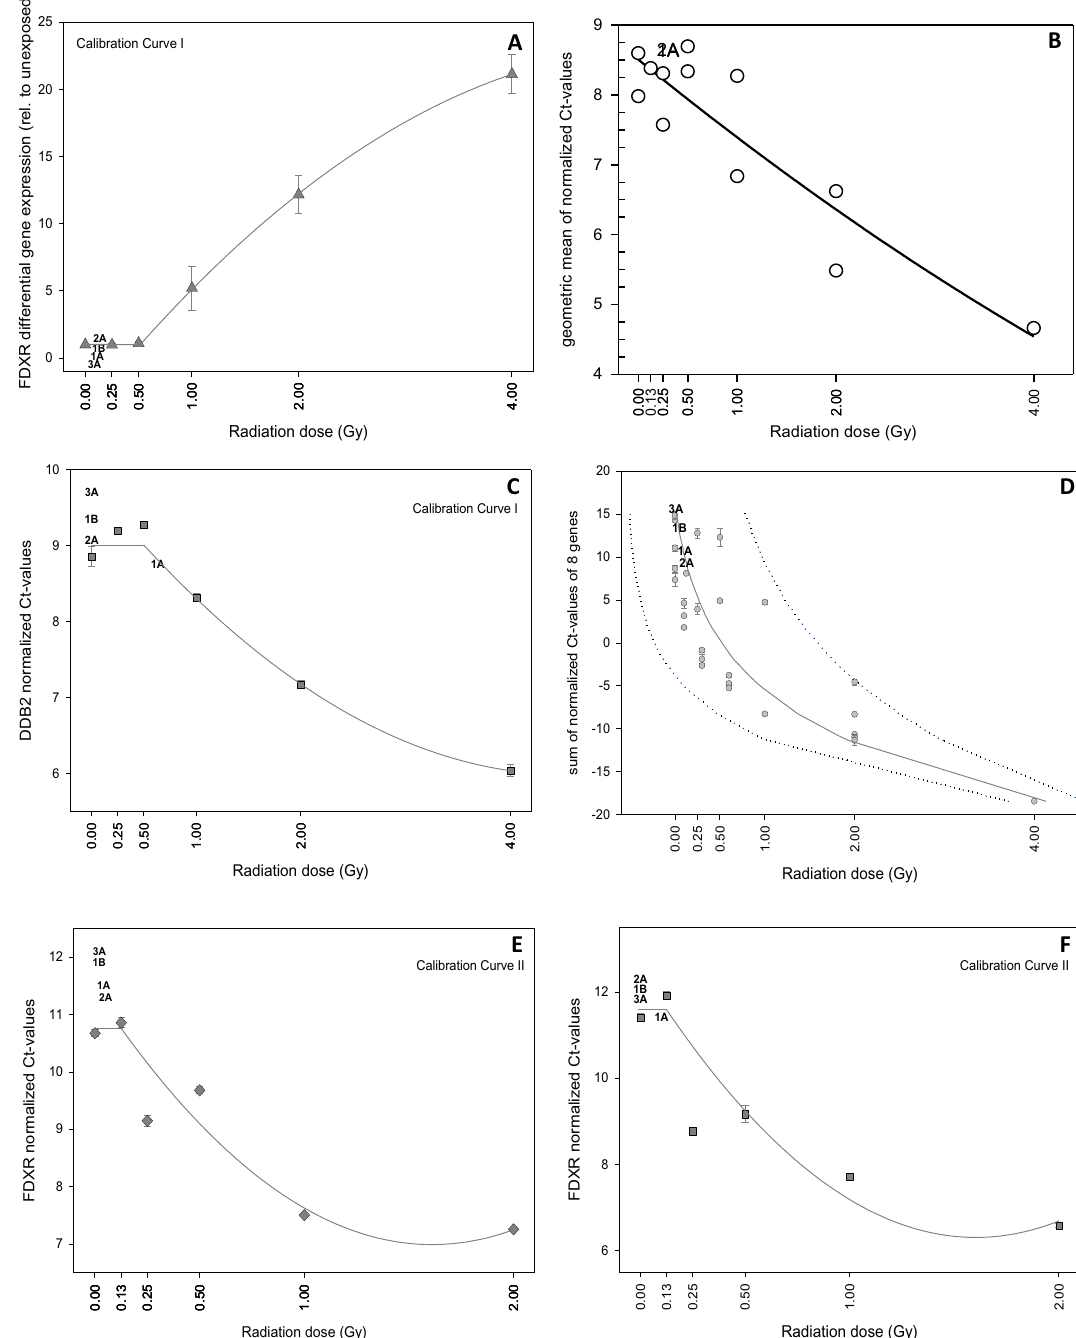
Figure 3. Examples of calibration curves I ( A , C ) and II ( E , F ) and additional calibration curves combined ( B , D ) generated by the different qRT-PCR teams are shown. Gene expression reflected either as differential gene expression (reference was the 0 Gy calibration sample, A ), normalized single genes from two different teams ( C , E , F ), averaged ( B ) or summed Ct-values ( D ) using several genes combined were plotted versus radiation dose (Gy). Normalized and differential gene expression values measured below 0.5–1.0 Gy (calibration curve I) and 0.125 Gy (calibration curve II) were fitted with a horizontal line (assuming a threshold) and higher values using a manual fit. For summed normalized Ct-values of 8 genes ( BAX, BBC3, CDKN1A, DDB2, FDXR, GADD45A, GDF15, TNFSF4 ) and utilizing different calibration curves an exponential fit was used and the 95% confidence intervals were plotted using a dotted line. As an example a linear-quadratic fit was used in ( B ) (details are presented in Supplemental File 1). Error bars represent standard deviation from duplicate measurements except for ( A ), where duplicate measurements were performed by each of three different individuals. Error bars are visible when larger than the symbols. Blinded samples 1A, 1B, 2A and 3A corresponding to the team’s calibration curve are superimposed in the panels and sometimes overlapping each other, because of very similar values (graph created using SigmaPlot Version 14.0, http:// www. systa tsoft ware.